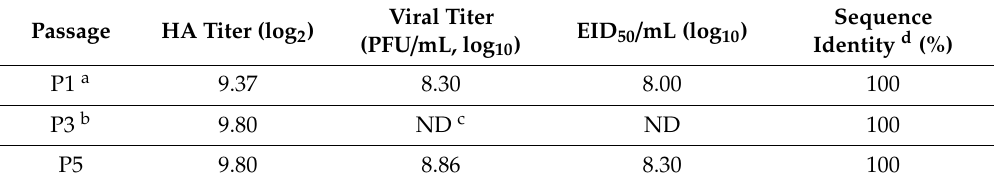
a Data for P1 represent the average value of all allantoic samples from three independent transfection and egg infection experiments; b Data for P3 and P5 represent the average value of ten allantoic samples from